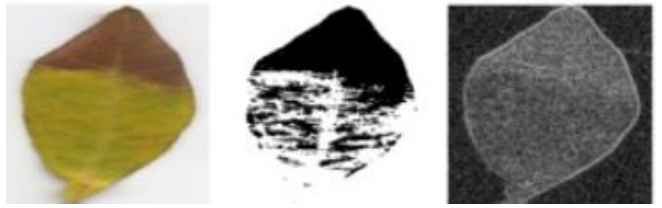
Figure 10. Activation visualization for detection of apple plant disease to show the significance of a VGG-Inception model (the plant disease is indicated by the red circle) [85].